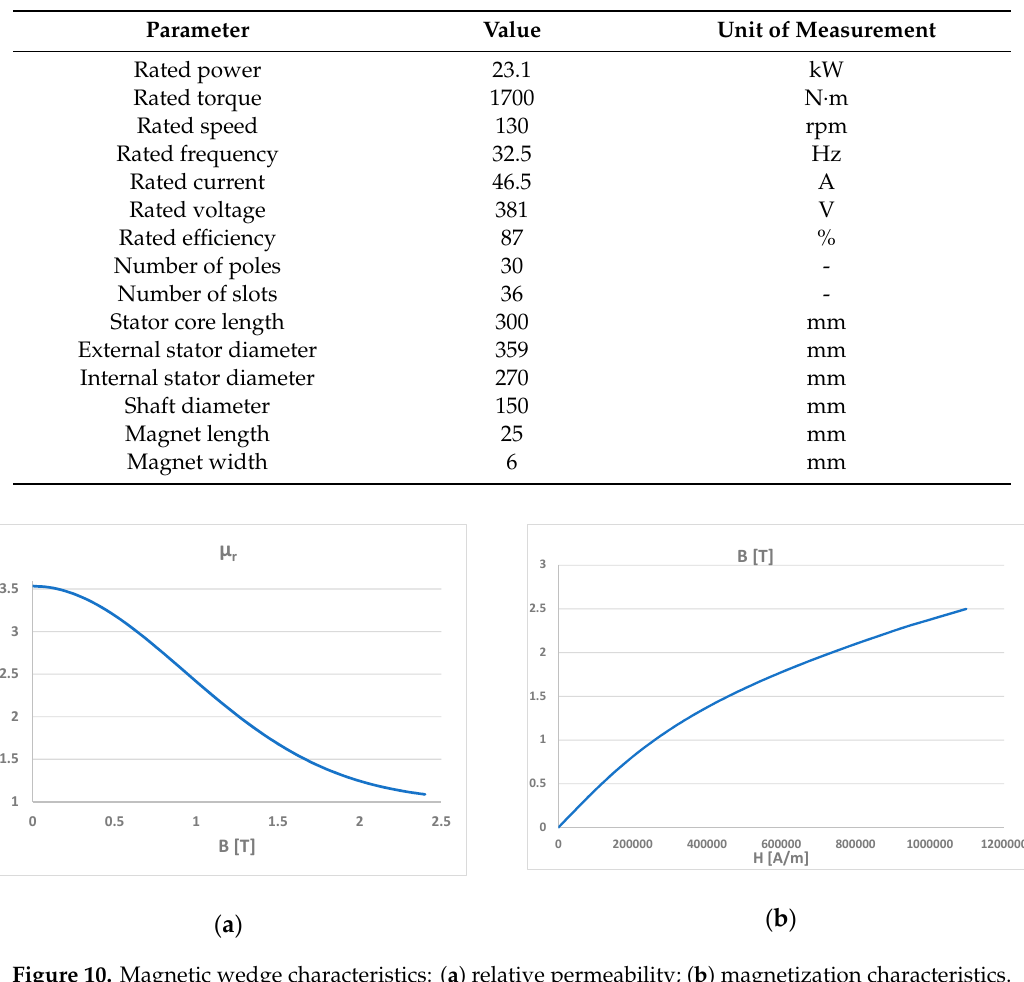
Table 3. Main data of the analyzed motor.